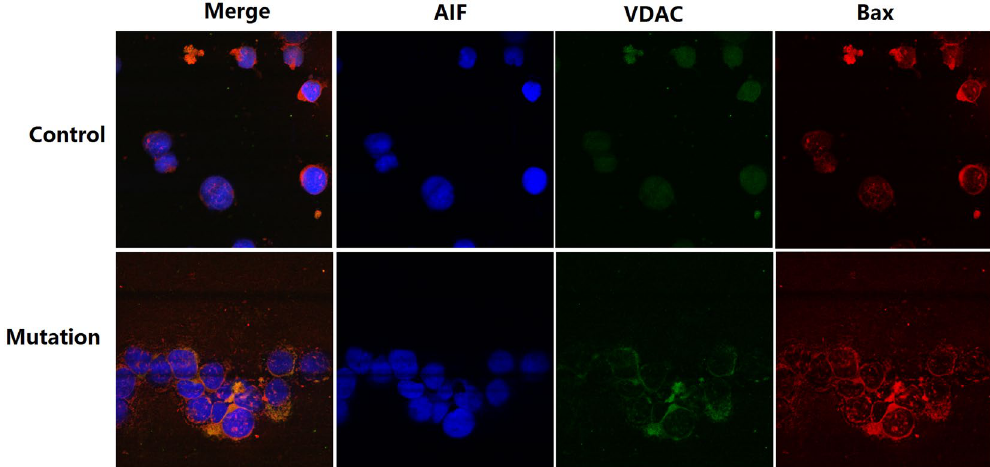
Figure 7. VDAC, BAX and AIF co-localization in lymphocytes by immunofluorescence. AIF is labeled with blue fluorescence, Bax is labeled with red fluorescence, and VDAC is labeled with green fluorescence. The control cell line exhibited no colocalization (yellow fluorescence) of Bax and VDAC or Bax and AIF (purple fluorescence). The mutant cell line showed the colocalization (yellow fluorescence) of Bax and VDAC but not the colocalization of Bax and AIF (purple